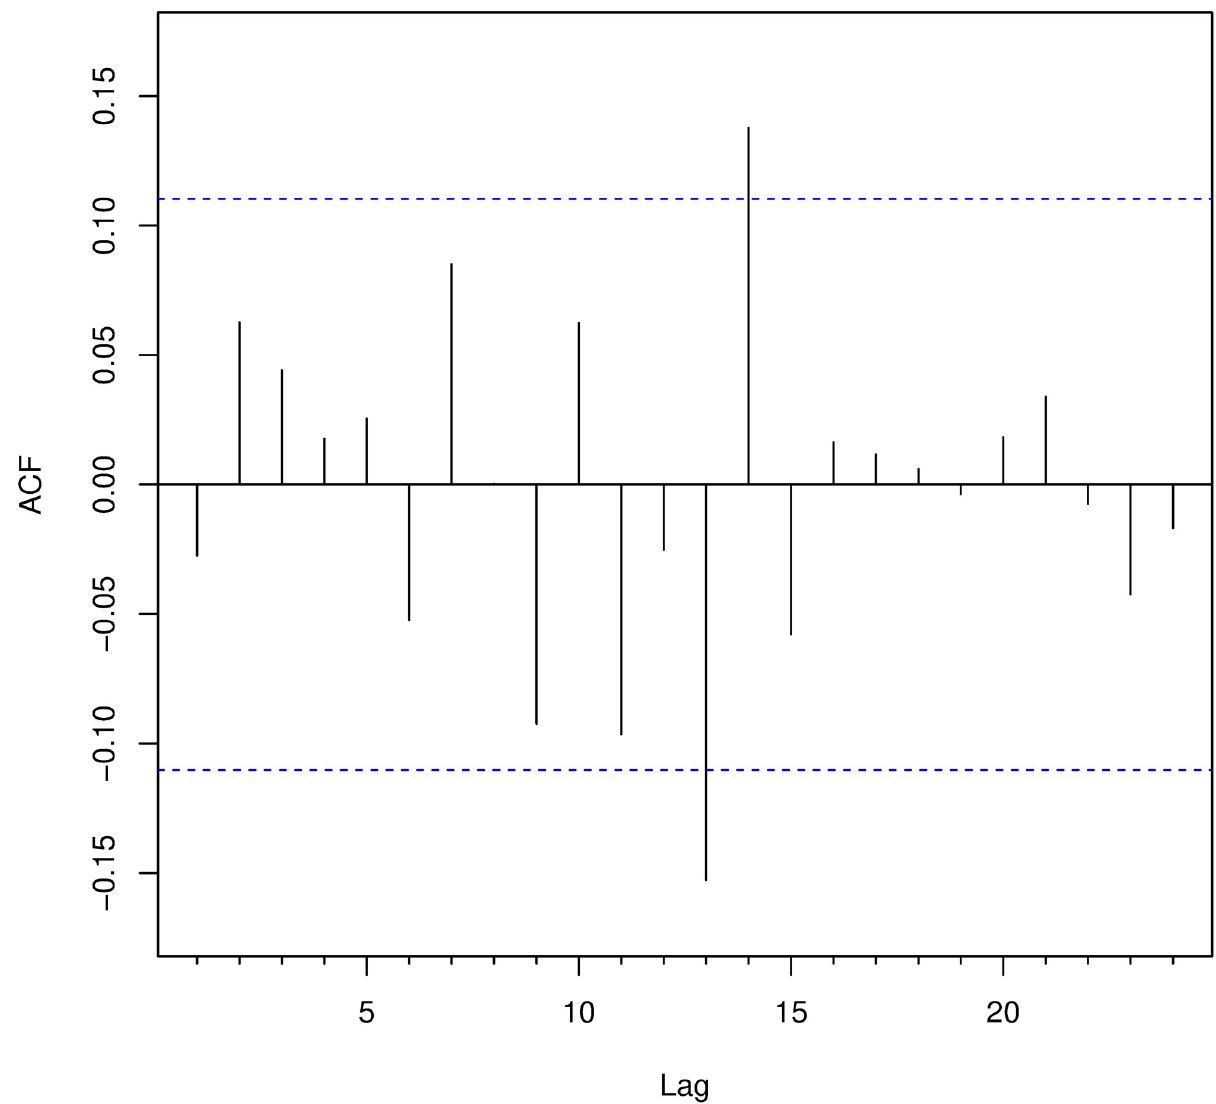
Fig 9. Autocorrelation function of inter-arrival